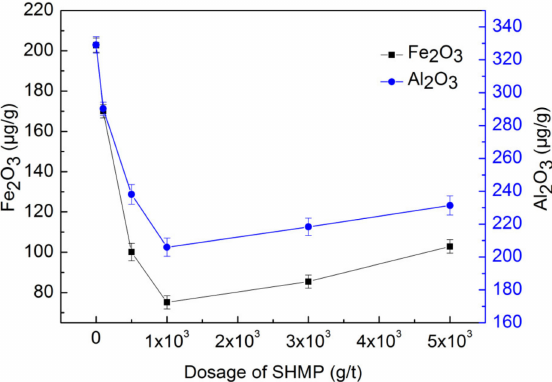
Figure 8. Effect of SHMP on the removal efficiency of impurities in